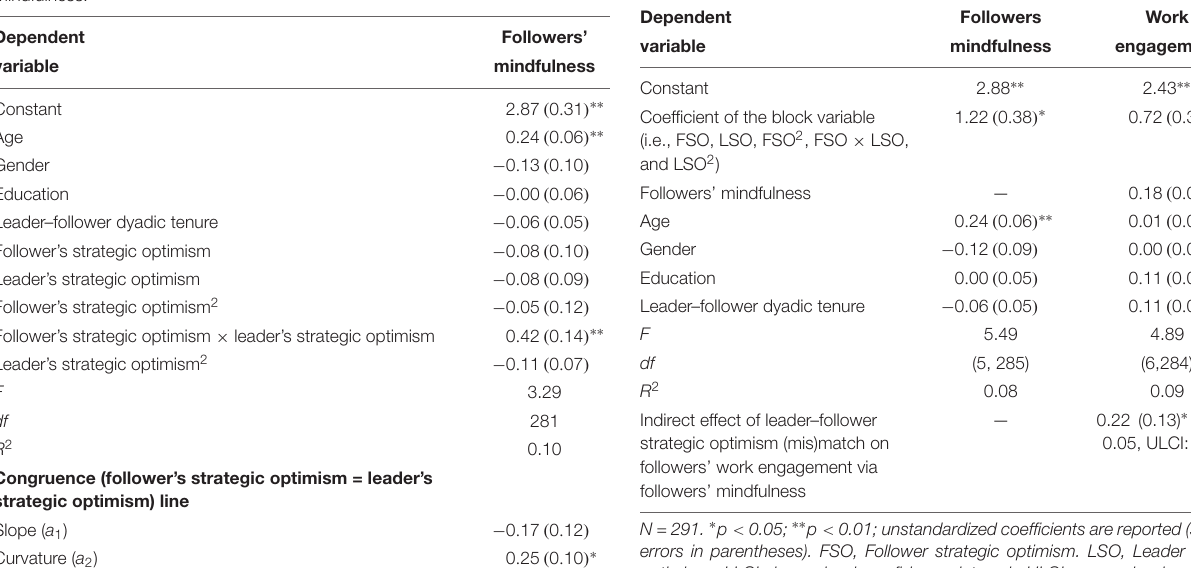
TABLE 2 | Polynomial regression analyses results predicting followers’ mindfulness.